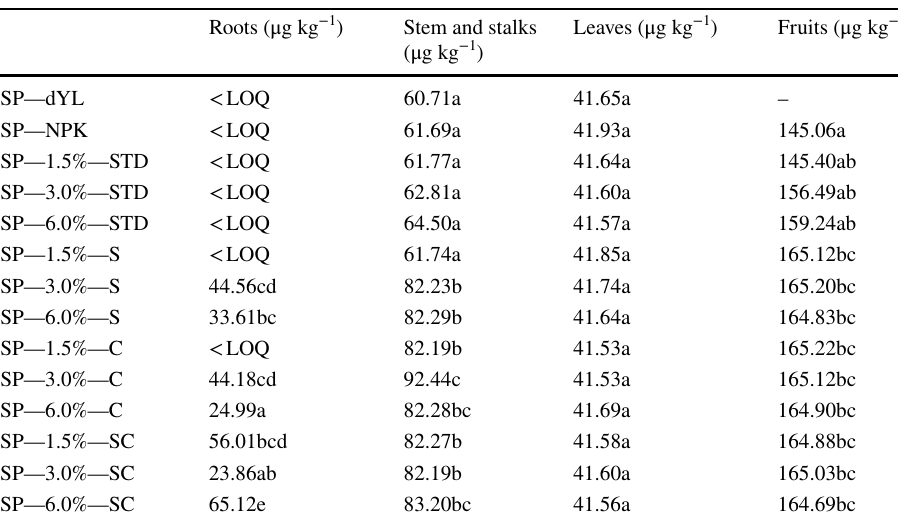
Table 8 Chromium distribution in vegetal tissues and organs (roots, stems, stalks, leaves and fruits) of sweet peppers